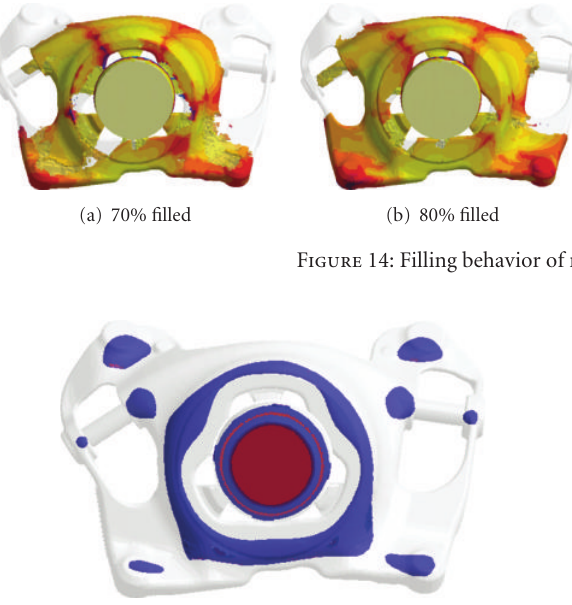
Figure 15: Solidification behavior of module bracket by rheology forging.